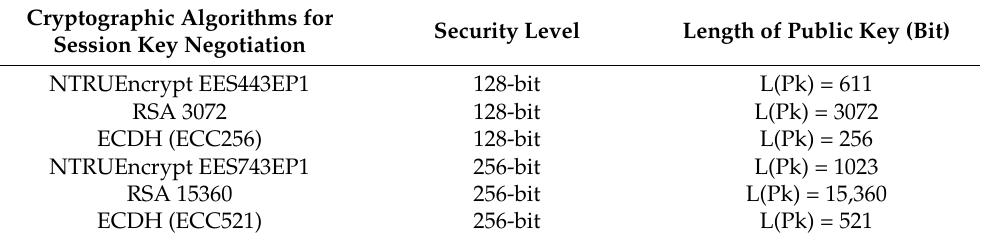
Table 4. Algorithms studied in this paper, their security level, and length of public key. Cryptographic Algorithms